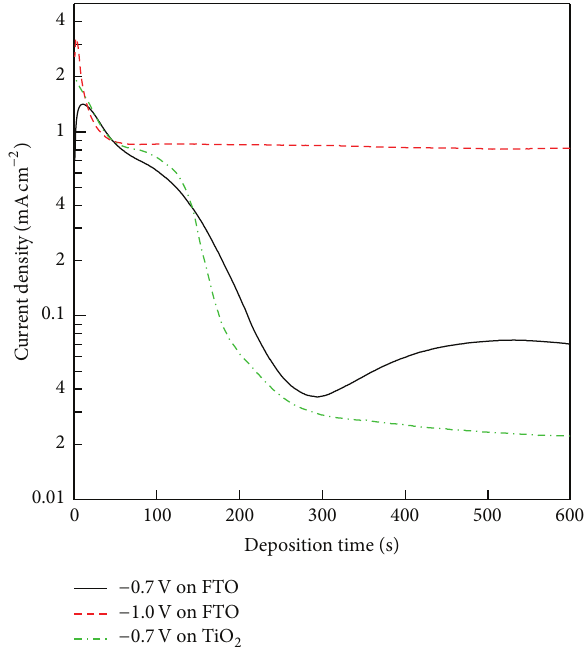
Figure 2: Time-electrodeposition current curves at the selenium electrodeposition at − 0.7 V and − 1.0V (versus Ag/AgCl) using FTO electrodes and at − 0.7 V (versus Ag/AgCl) using TiO 2